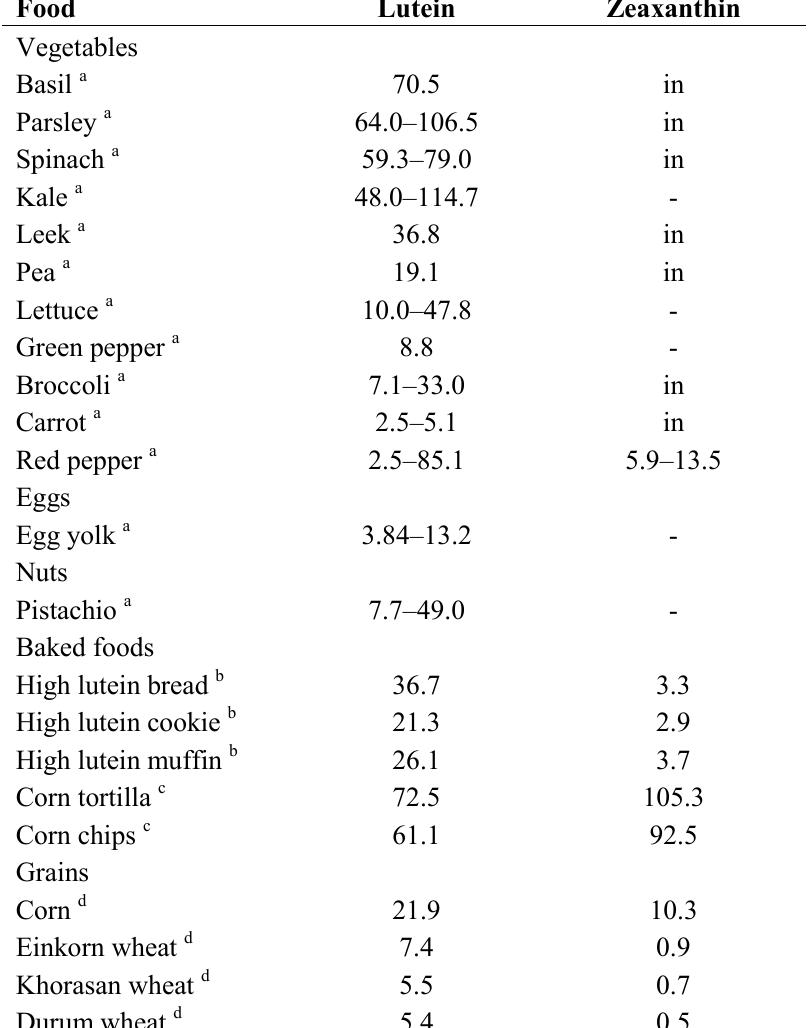
Table 1. Selected commonly consumed foods as high sources of xanthophylls (µg/g fresh weight except for corn tortilla and chips µg/g dry matter)